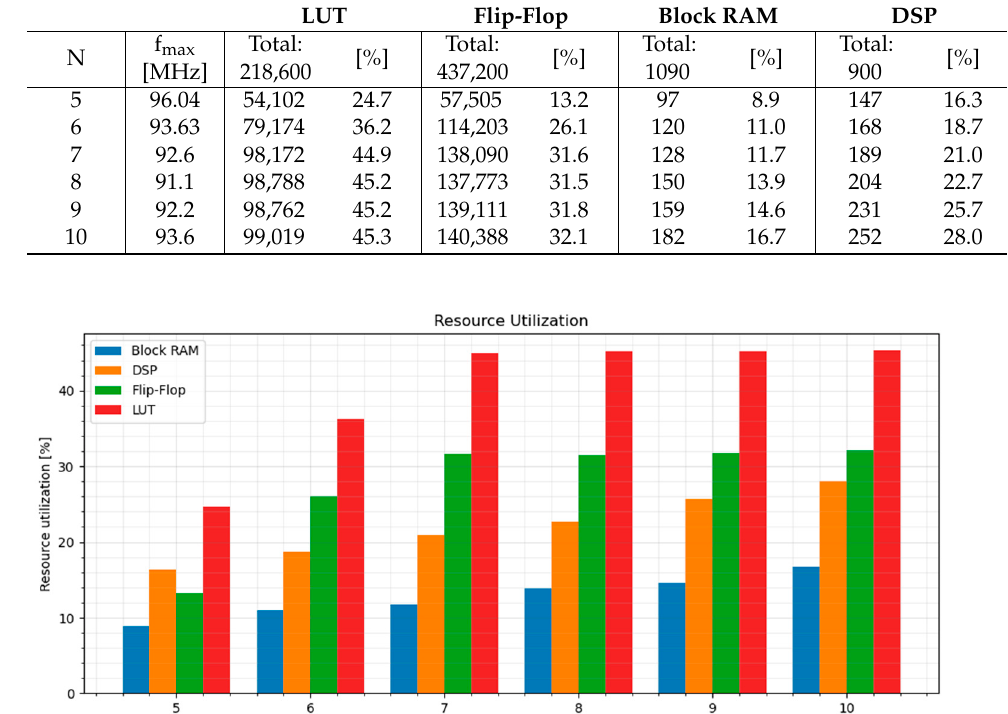
Table 2. Utilization report of the implemented design at N = 10. * The AXI Interconnect component is a Xilinx IP block. The processing system (ARM Cortex PS) is implemented in silicon but requires some logic utilization for interfacing.